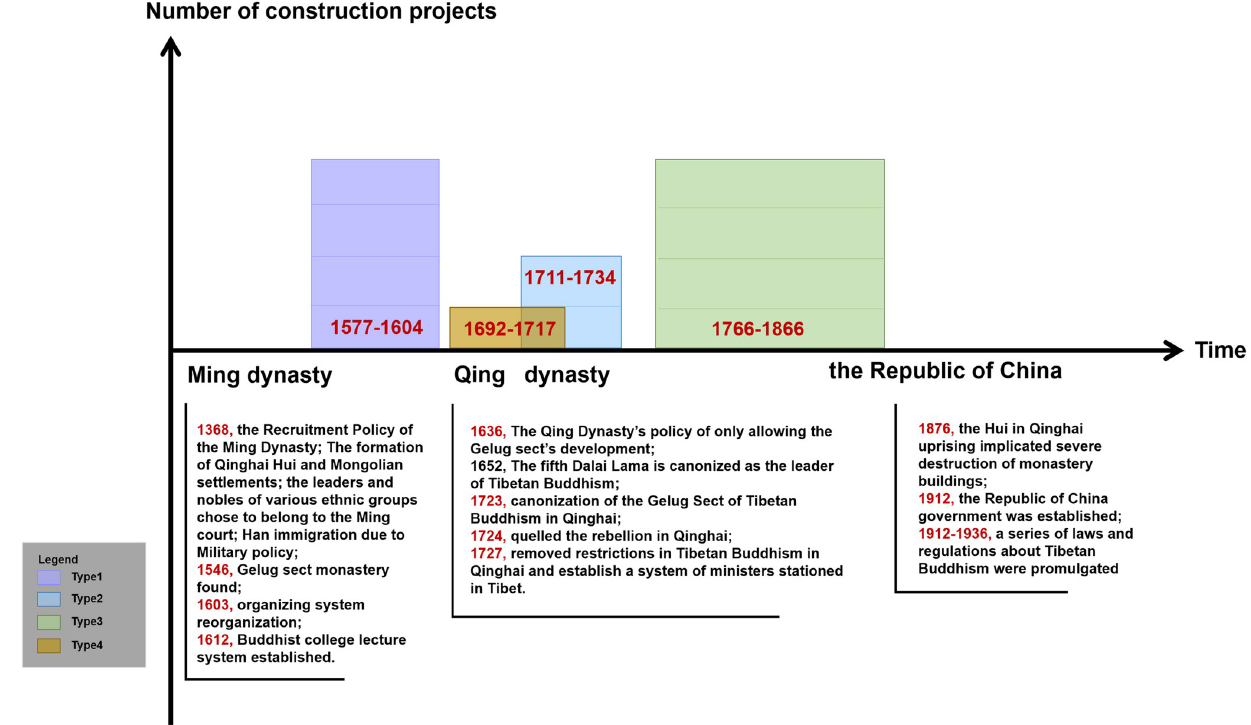
Fig 15. Evolution of 4 types of palace buildings in Kumbum